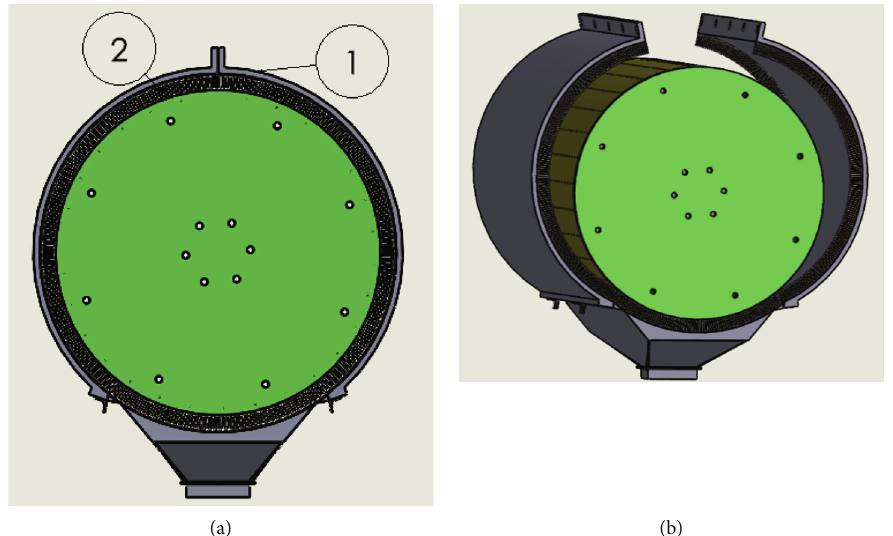
Figure 11: Door container, (a) front view, (b) isometric